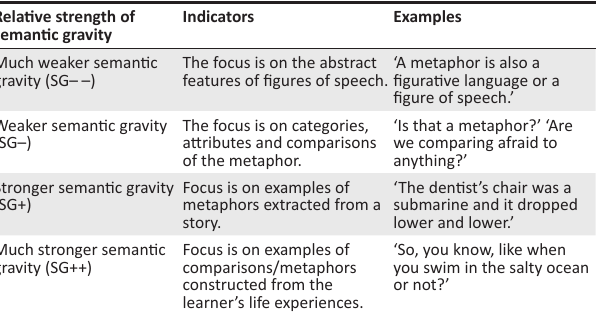
TABLE 1: Translation device that defines four strengths of semantic gravity used to code context-dependence of knowledge in a Grade 3 lesson on poetic devices. Relative strength of Indicators semantic gravity